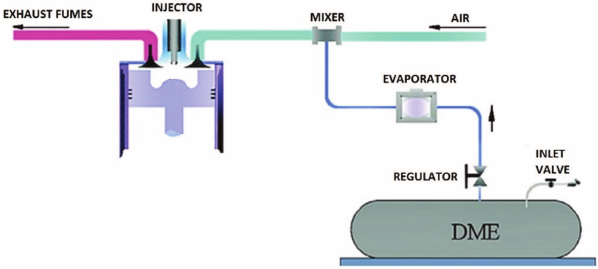
Fig. 3. Schematics of the system for the adaptation of a diesel engine to dimethyl ether fueling